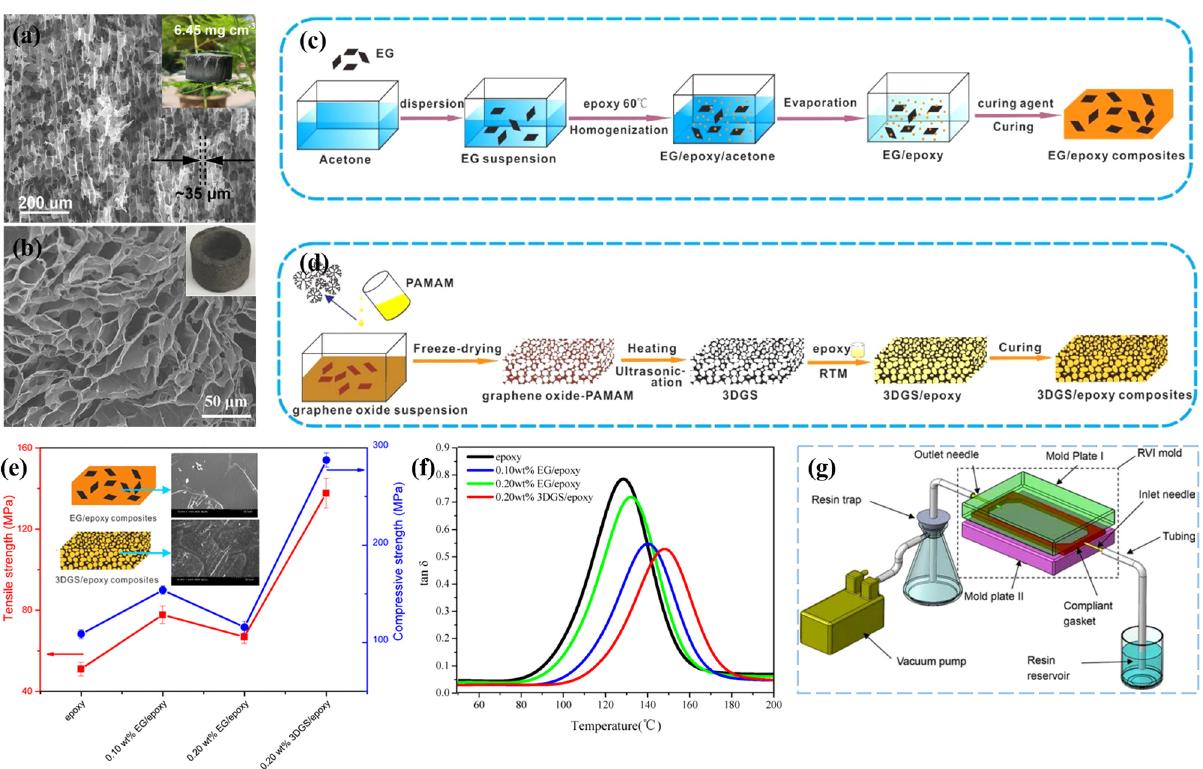
Figure 2: The SEM images and their corresponding objects of ( a ) aerogel [ 25 ] ( Copyright 2021, American Chemical Society ) and ( b ) high - density sponge [ 26 ] ( Copyright 2018, Wiley ) . Preparation of EP/GO composites by ( c ) direct mixing and ( d ) vacuum seepage. ( e ) Mechanical properties and ( f ) thermal stability of Ep/graphene composites [ 27 ] ( Copyright 2015, American Chemical Society ) . ( g ) Schematic diagram of high - speed seepage device [ 29 ] ( Copyright 2016, Taylor & Francis )